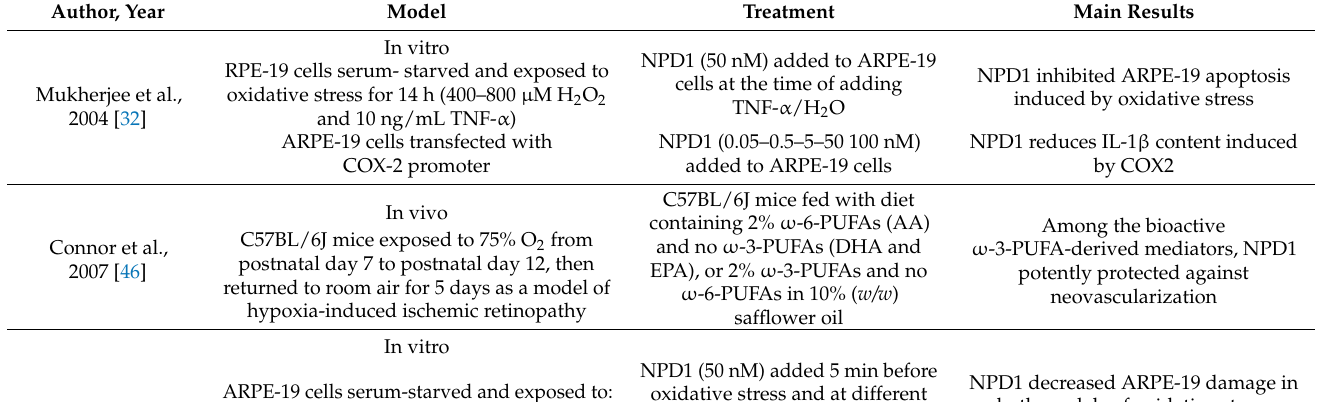
Table 3. NPD1 and retinal